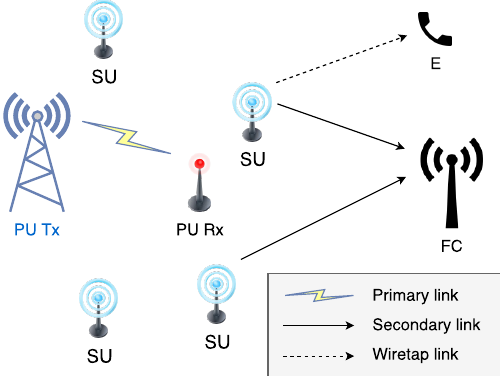
Figure 1. The model of the system considered in this paper. E: eavesdropper; FC: fusion